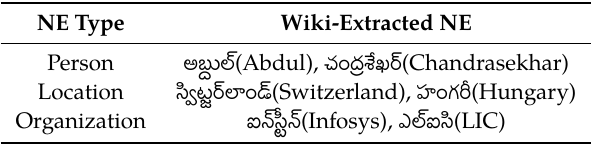
Table 3. Example of named entity instances extracted from